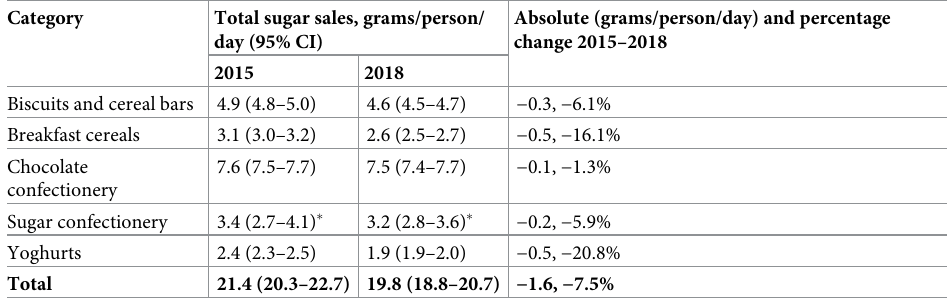
Table 5. Total volume of sugars sold by food category in per capita per day terms, 2015–2018.